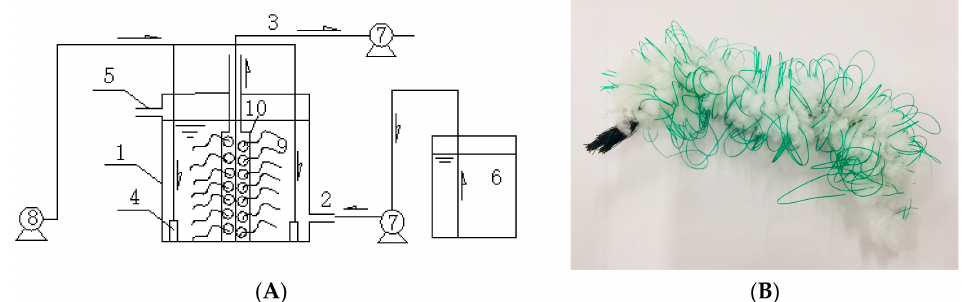
Figure 1. ( A ) Scheme of the sequencing biofilm batch reactor: (1) bioreactor; (2) influent; (3) effluent; (4) diffusers; (5) overflow pipe; (6) inlet tank; (7) peristaltic pump; (8) air compressor; (9) biofilm carrier; and (10) water collector; and ( B ) a photo of the biofilm